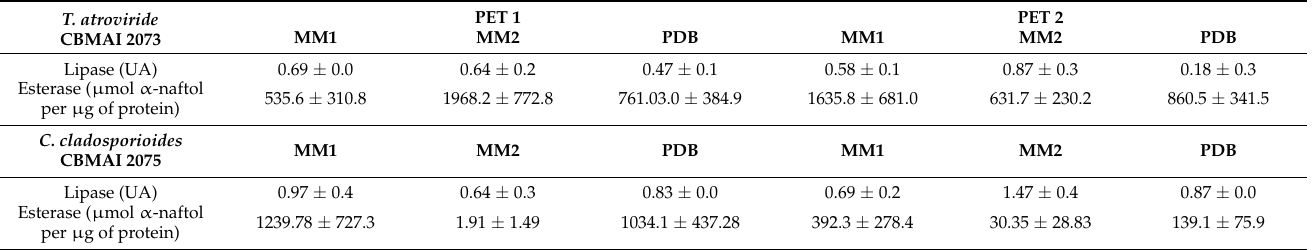
(Results expressed as mean ± standard deviation, n = 3). Fermentation time = 40 days, 28 ◦ C at 150 rpm. PET1 = PET water bottle fragments (Crystal ® ); PET2 = PET soft drink bottle fragments (Sprite ® ); MM1 = mineral medium supplemented with glucose and sucrose; MM2 = mineral medium supplemented with palm oil; and PDB = Potato dextrose broth (Sigma ®